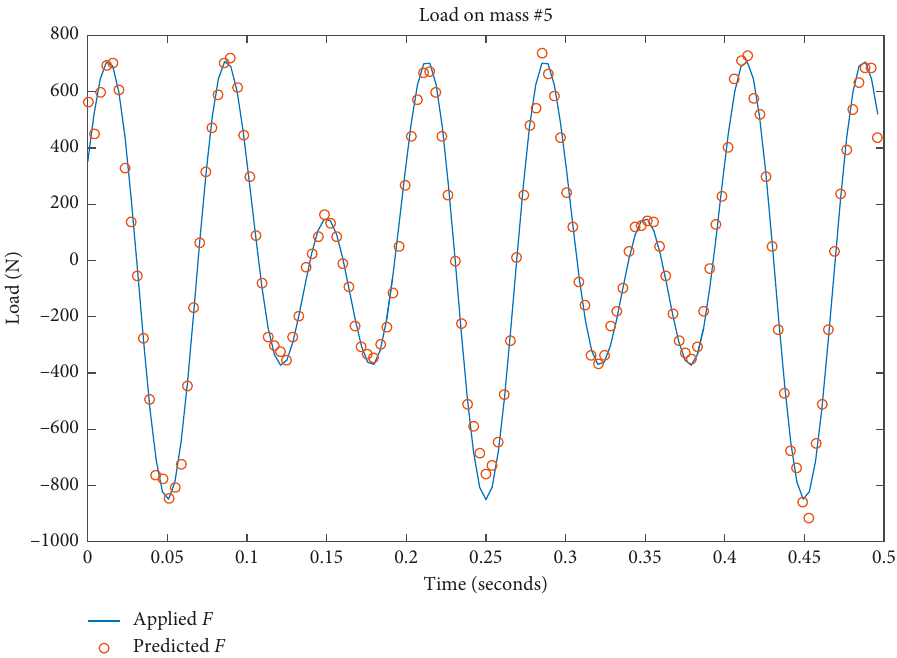
Figure 7: Applied and reconstructed load at mass